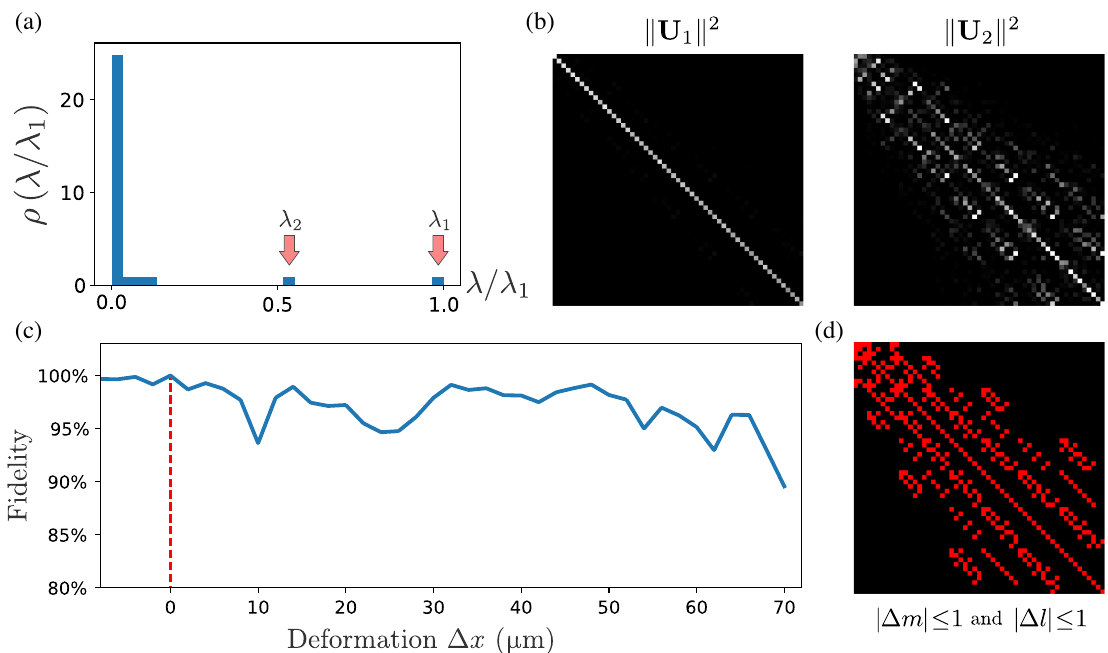
FIG. 4. Analysis of the effect of deformations. (a) Singular value distribution of the deformation operator representing the full range of deformations. (b) Intensity of the first two singular components U 1 and U 2 . (d) Matrix representing the coupling between close-by modes, i.e., with a radial order l difference equal or lower than 1 and an orbital momentum m difference equal or lower than 1. (c) Fidelity between the measured TM in the mode basis and the approximated one using Eq. (5) (blue line). The fidelity is defined similarly as in the caption of Fig.